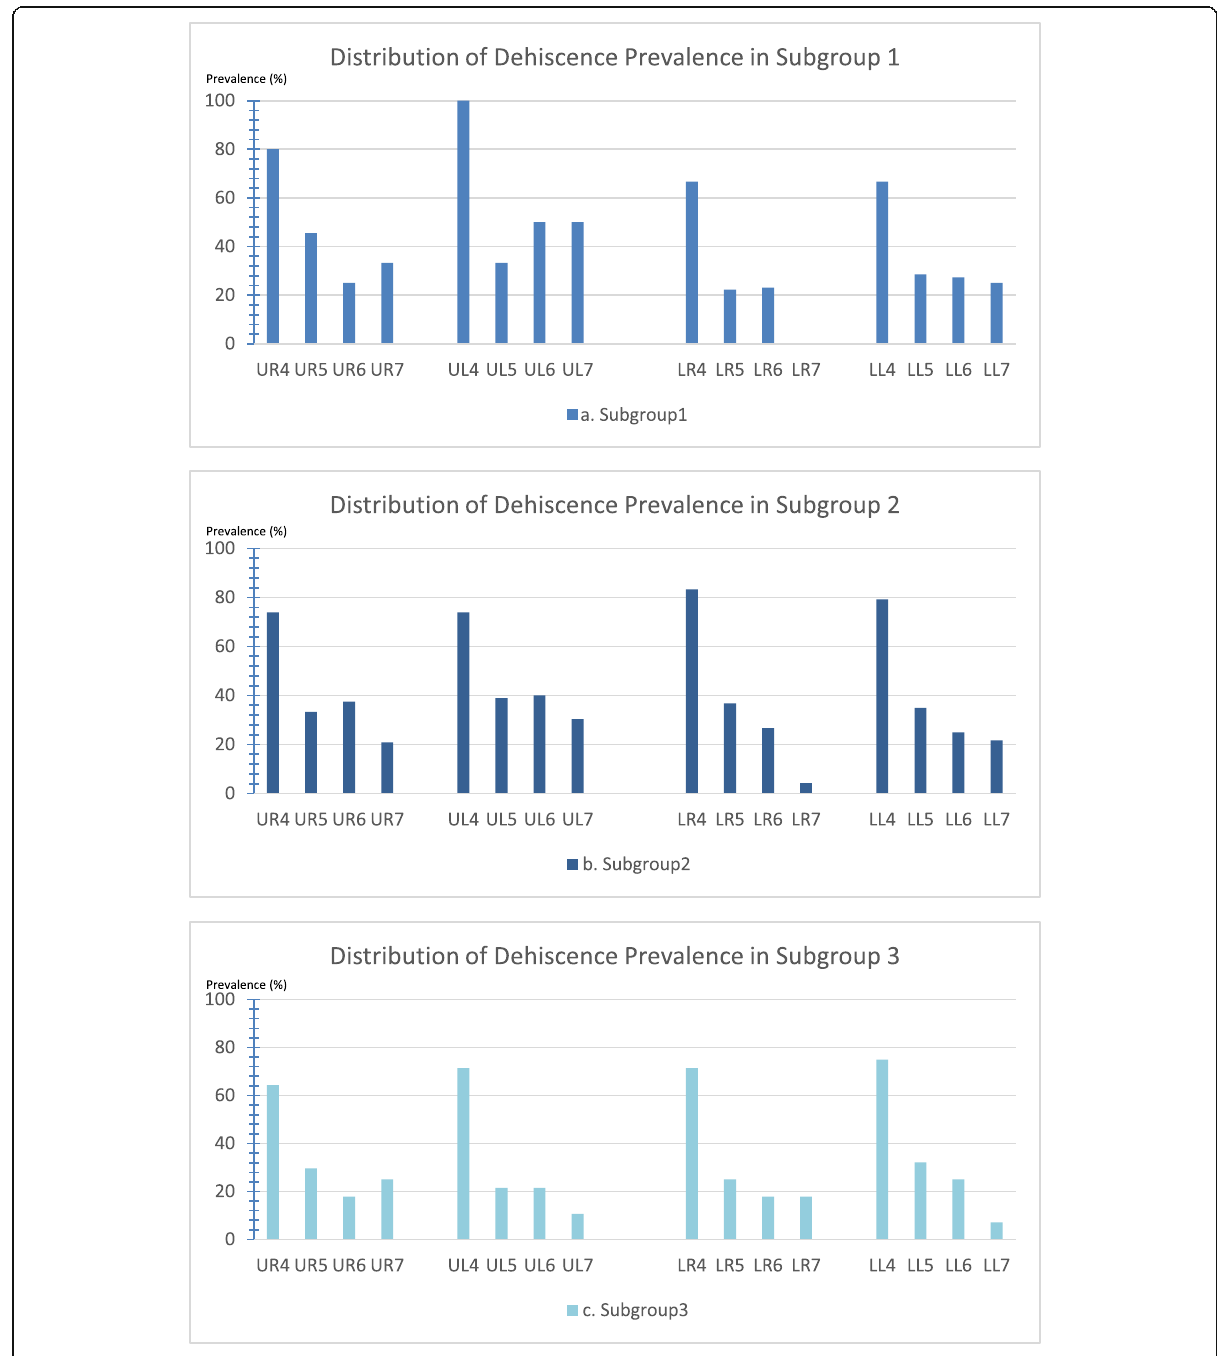
Fig. 2 Distribution of the dehiscence prevalence among the posterior teeth by subgroup. a Subgroup 1, the crossbite teeth in the study group. b Subgroup 2, the noncrossbite teeth in the study group. c Subgroup 3, the noncrossbite teeth in the comparison